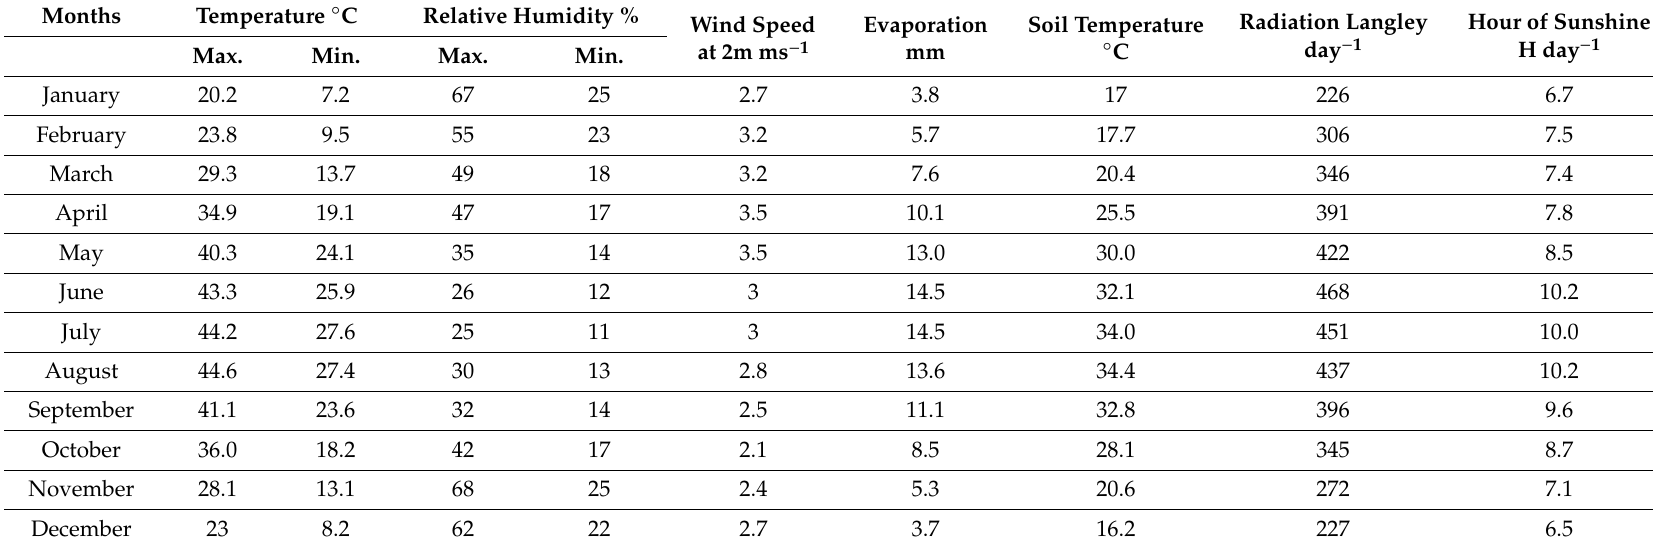
Table 3. The average of climate conditions in the study area